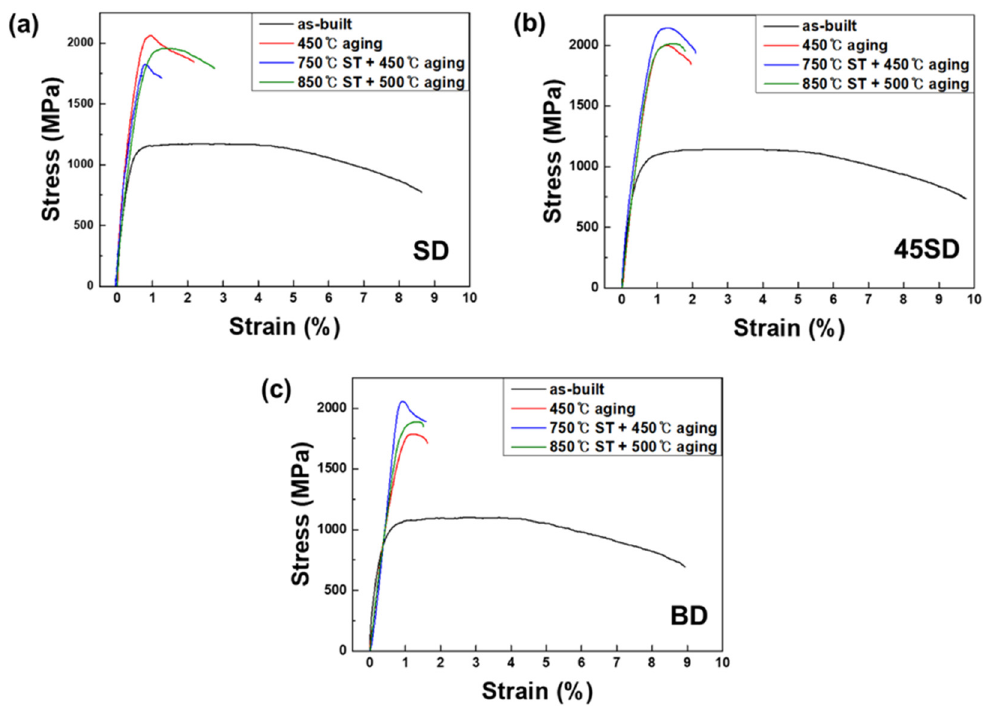
Figure 10. Tensile stress–strain curves for maraging steels produced by SLM with different heat treatments, along with direction: ( a ) SD; ( b ) 45SD; and ( c ) BD.